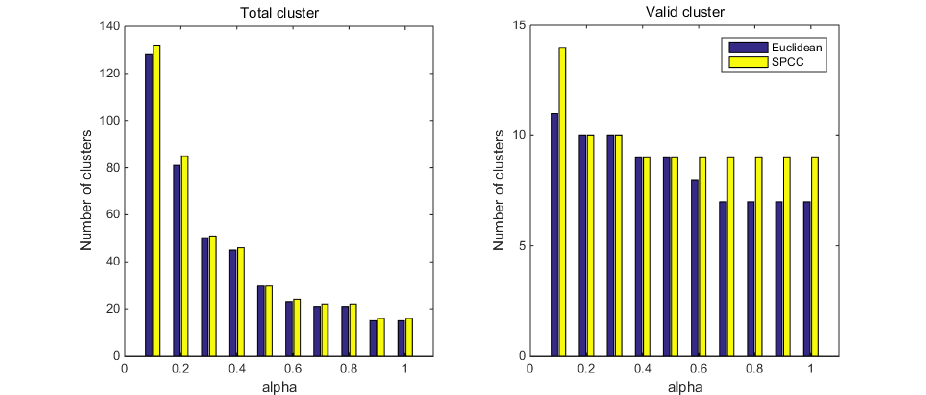
Figure 11. Comparison in number of clusters formed from KEPCO data